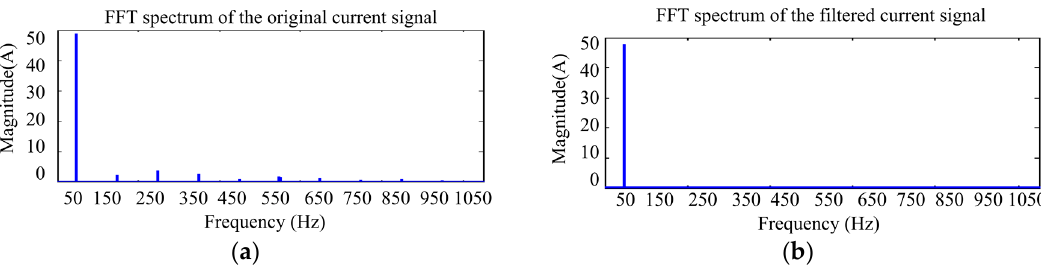
Figure 10. Main board MBD3 FFT spectrum at a time when stationary disturbances are present: ( a ) original current signal spectrum; and ( b ) filtered current signal around the fundamental frequency.